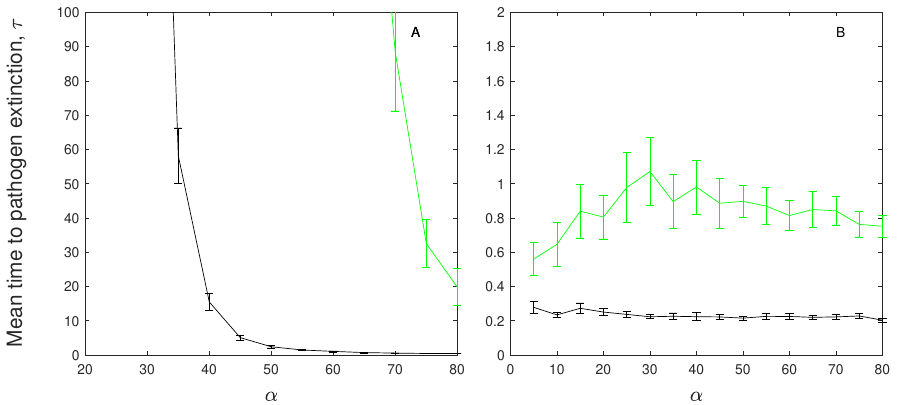
Figure 2. The mean time to pathogen extinction (with 95% confidence intervals) plotted against disease-induced mortality rate for ( A ) models without immunity: SIS (black) and SEIS (green), and ( B ) models with immunity: SIR (black) and SEIR (green). Also note the difference in vertical axis scale between A and B. When not changed in the figure baseline parameter values were used (see Table 2).